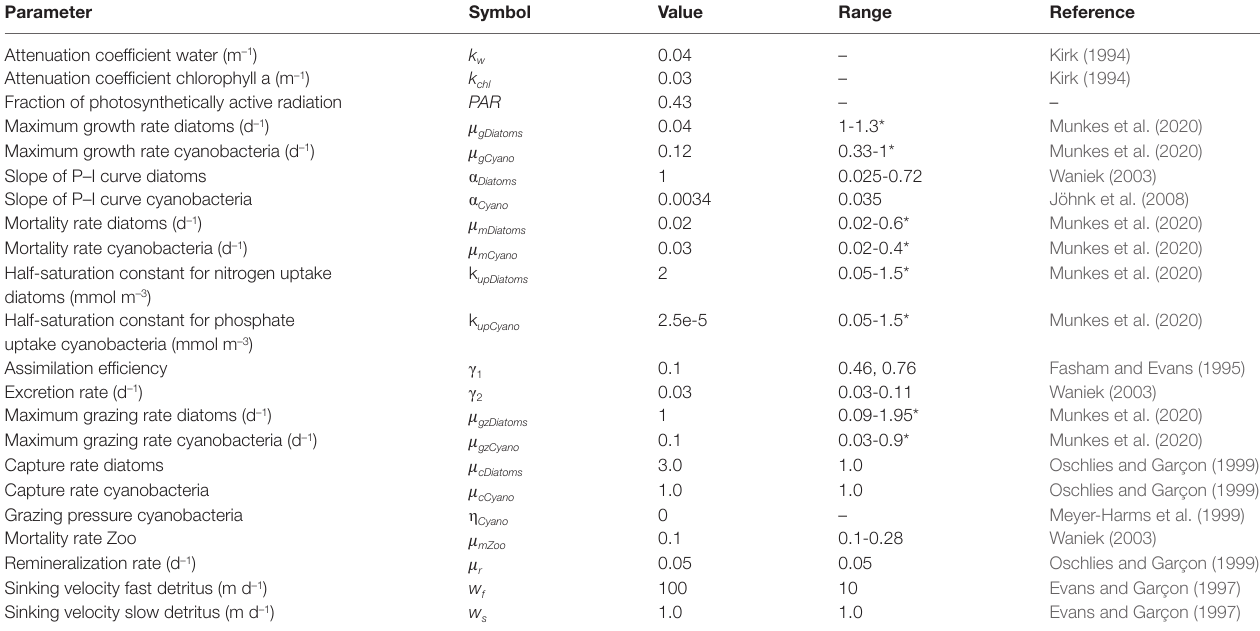
TABLE 2 | List of biological parameters used in the model. Parameter Symbol Value Range